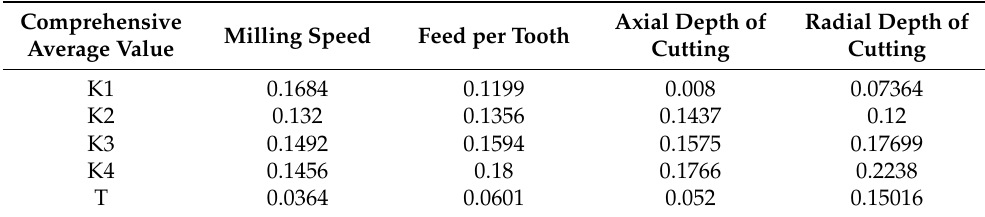
Table 3. Range analysis of each factor in orthogonal experiment.